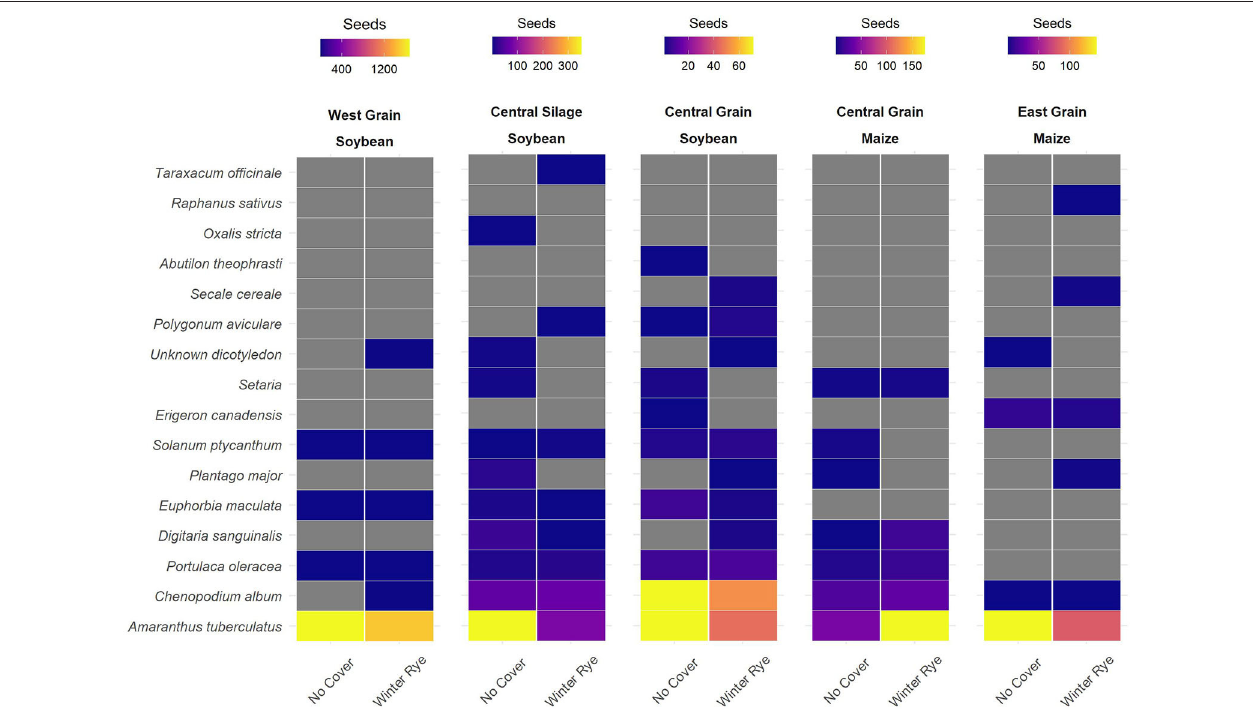
FIGURE 2 | Differences in winter rye ( Secale cereal ) cover crop and no-cover treatments were mainly observed in common waterhemp ( Amaranthus tuberculatus [Moq.]), with the cover crop treatment having lower numbers of waterhemp seeds in four of the five trials sampled.